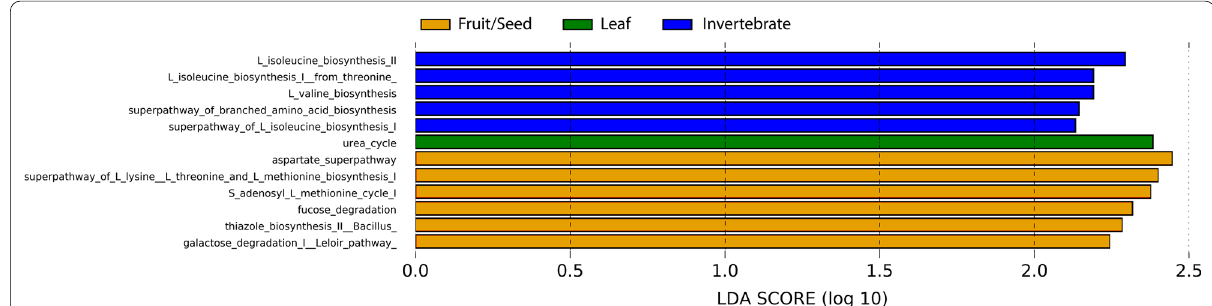
Fig. 6 Differentially abundant putative functions of the gut microbiota among the three dietary seasons estimated by